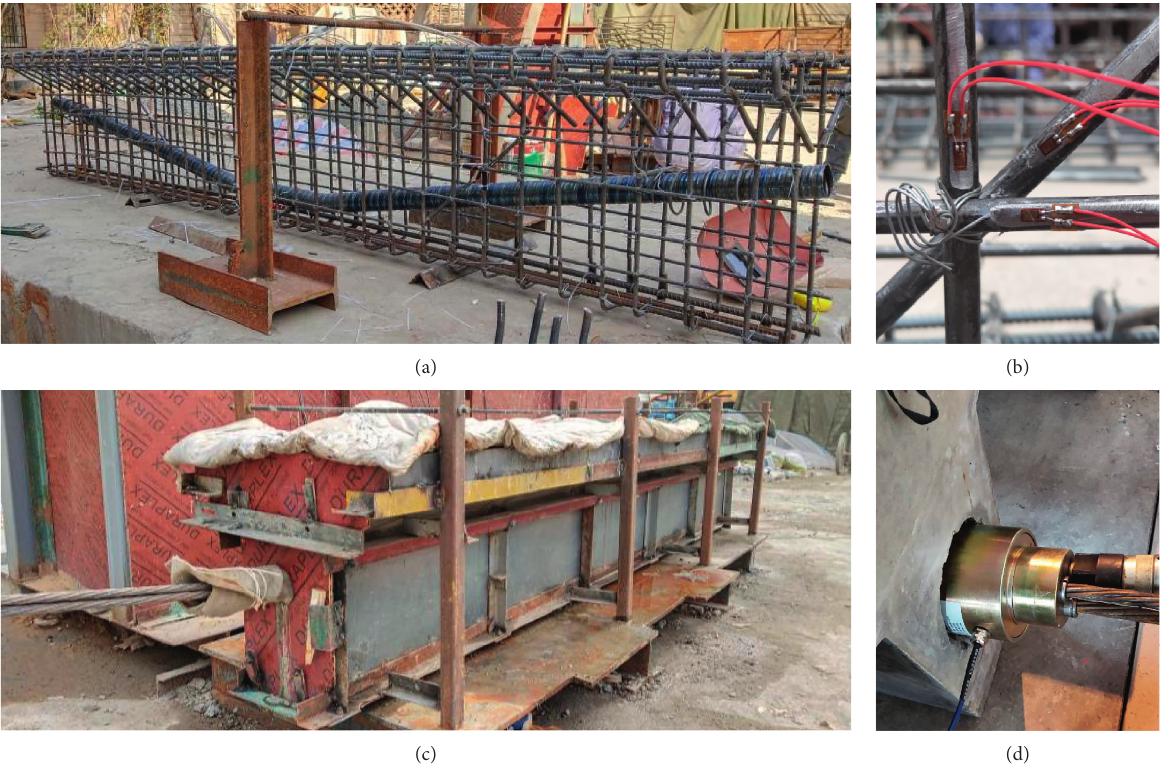
Figure 2: Fabrication procedure of T bridge girders. (a) Steel frame. (b) Strain gauges. (c) Concrete curing. (d) Pressure